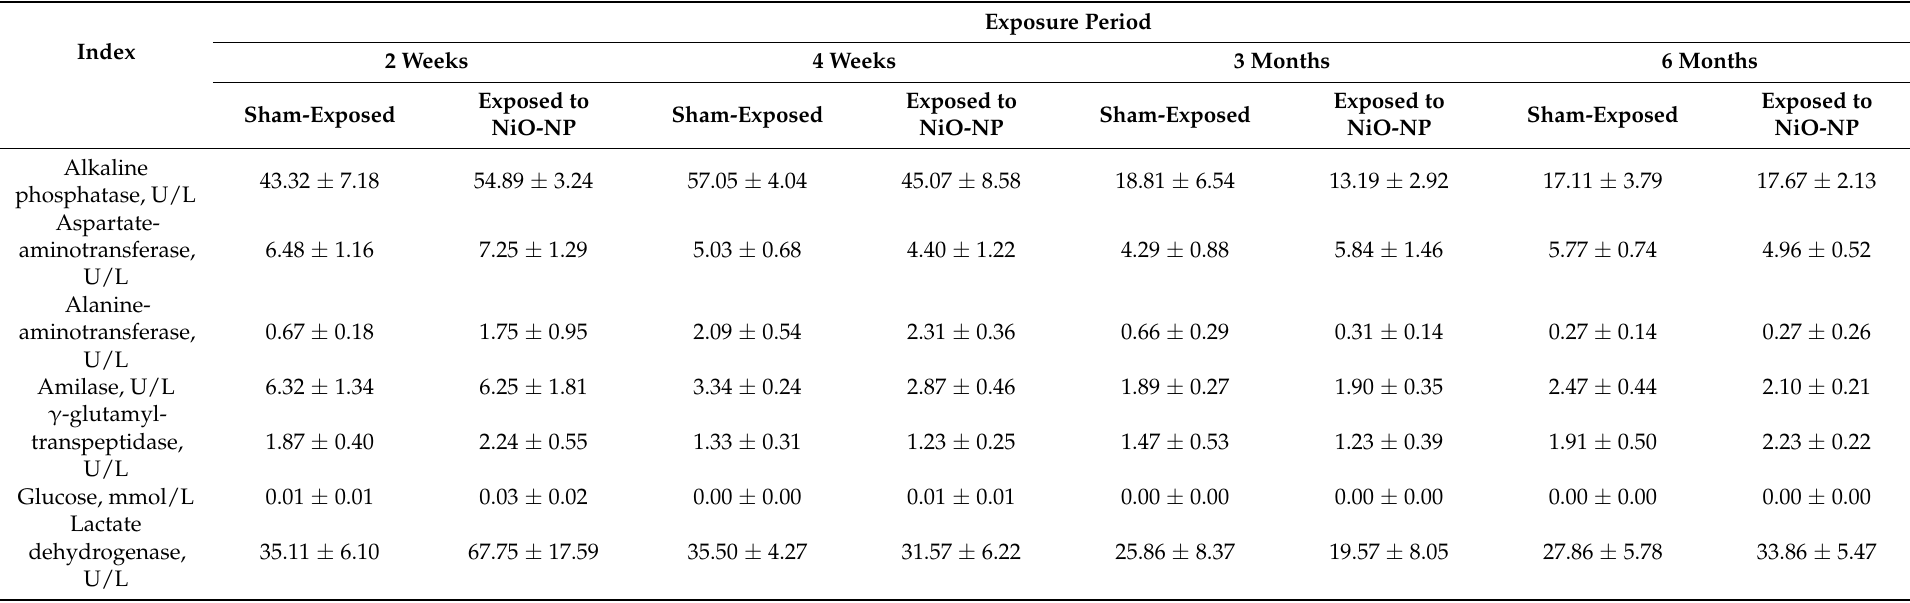
Table 2. Some biochemical indices in the BALF supernatant obtained 24 h after the last 4 h inhalation exposure to NiO-NP at 2.4 ± 0.4 µ g/m 3 ; ( x ± s.e.